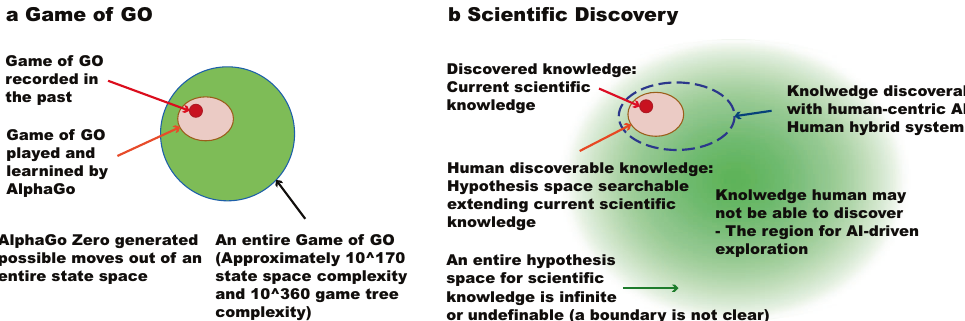
Fig. 2 A possible space of exploration by AI Scientists. Search space structures for a perfect information games as represented by the Game of GO and b scienti fi c discovery are illustrated with commonalities and differences. While the search space for the Game of GO is well-de fi ned, the search space for scienti fi c discovery is open-ended. A practical initial strategy is to augment search space based on current scienti fi c knowledge with human-centric AI-Human Hybrid system. An extreme option is to set search space broadly into distant hypothesis spaces where AI Scientist may discover knowledge that was unlikely to be discovered by the human scientist.